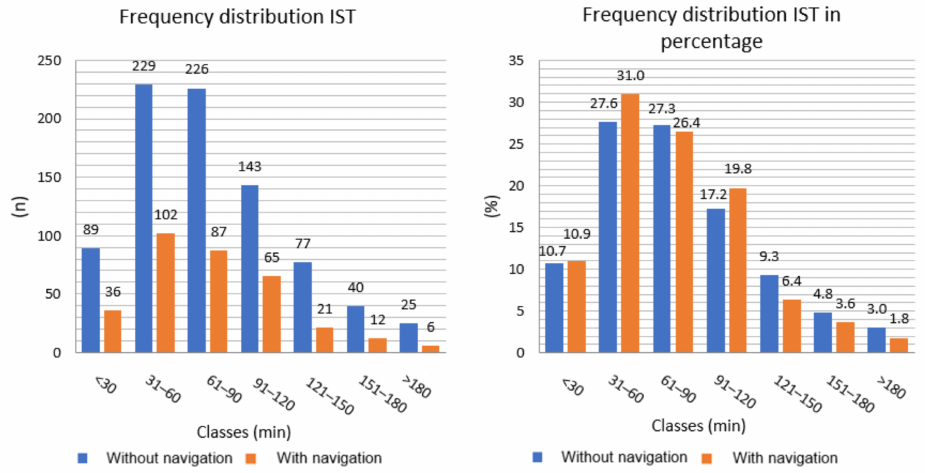
Figure 4. Frequency distribution incision–suture time (IST), both absolute and as a percentage.